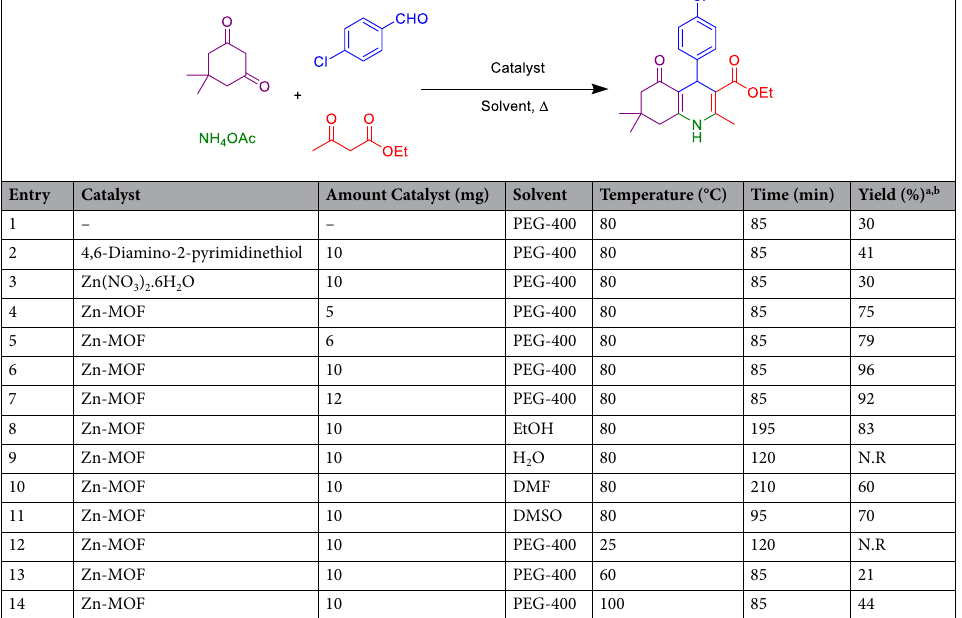
Table 1. Optimization of the reaction conditions for the Hantzsch condensation of para -Chlorobenzaldehyde, dimedone, ethyl acetoacetate, and ammonium acetate as the model reaction for the synthesis of polyhydroquinolines. a Isolated yield. b Reaction conditions: 4-Chlorobenzaldehyde (1 mmol),